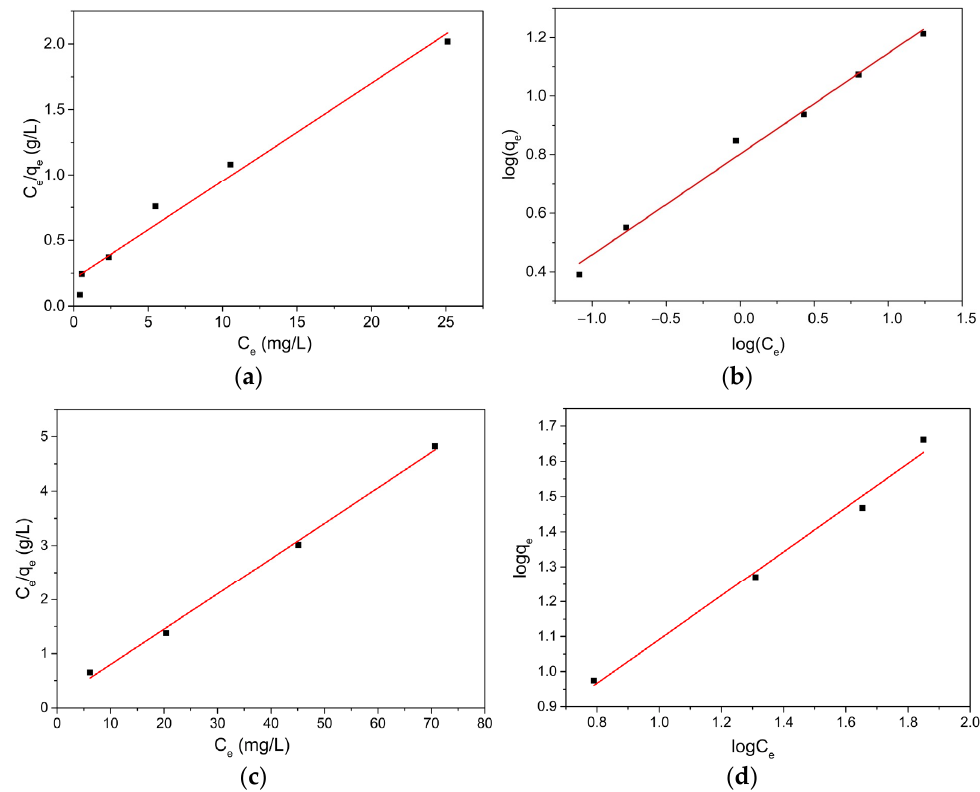
Figure 8. Langmuir adsorption model (( a ) MB and ( c ) PRM) and Freundlich adsorption model (( b ) MB and ( d ) PRM). Table 2. Langmuir and Freundlich parameters for MB and PRM adsorption while using the HCWS3